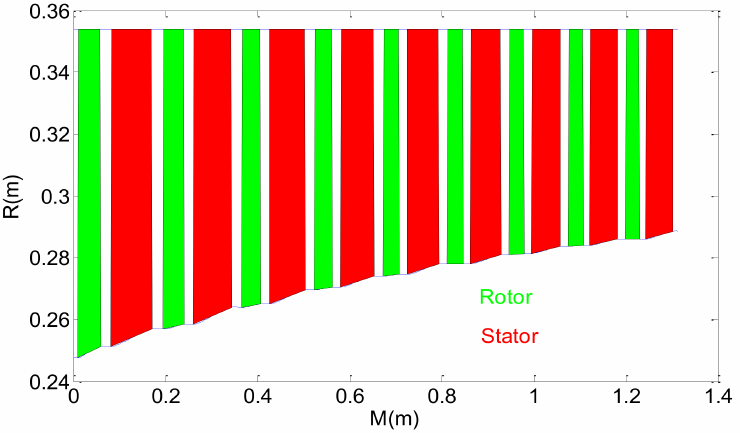
Figure 5. Meridional plane of the axial compressor for 100